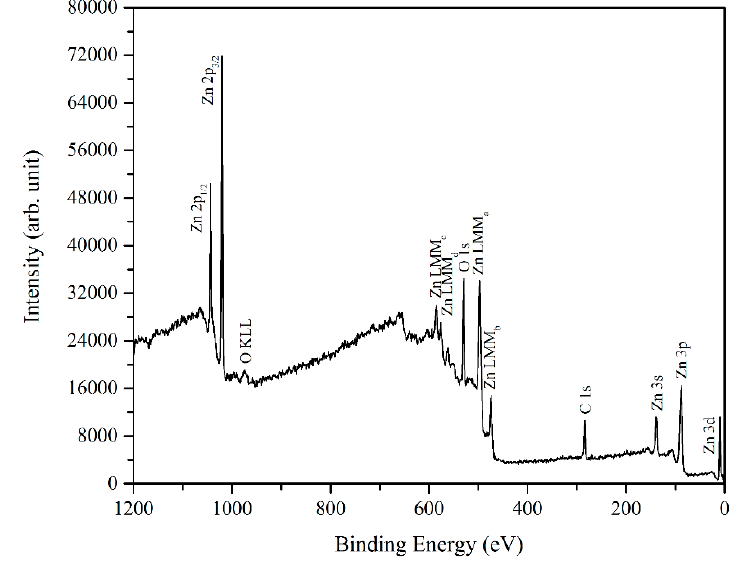
Figure 6. XPS wide scan of ZnO grown at 500 C.